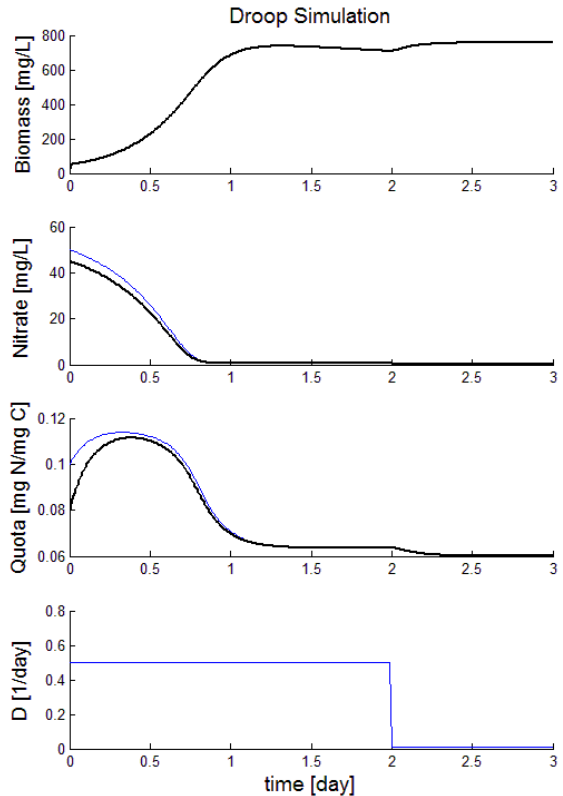
Figure 9. Estimated states in a microalgal